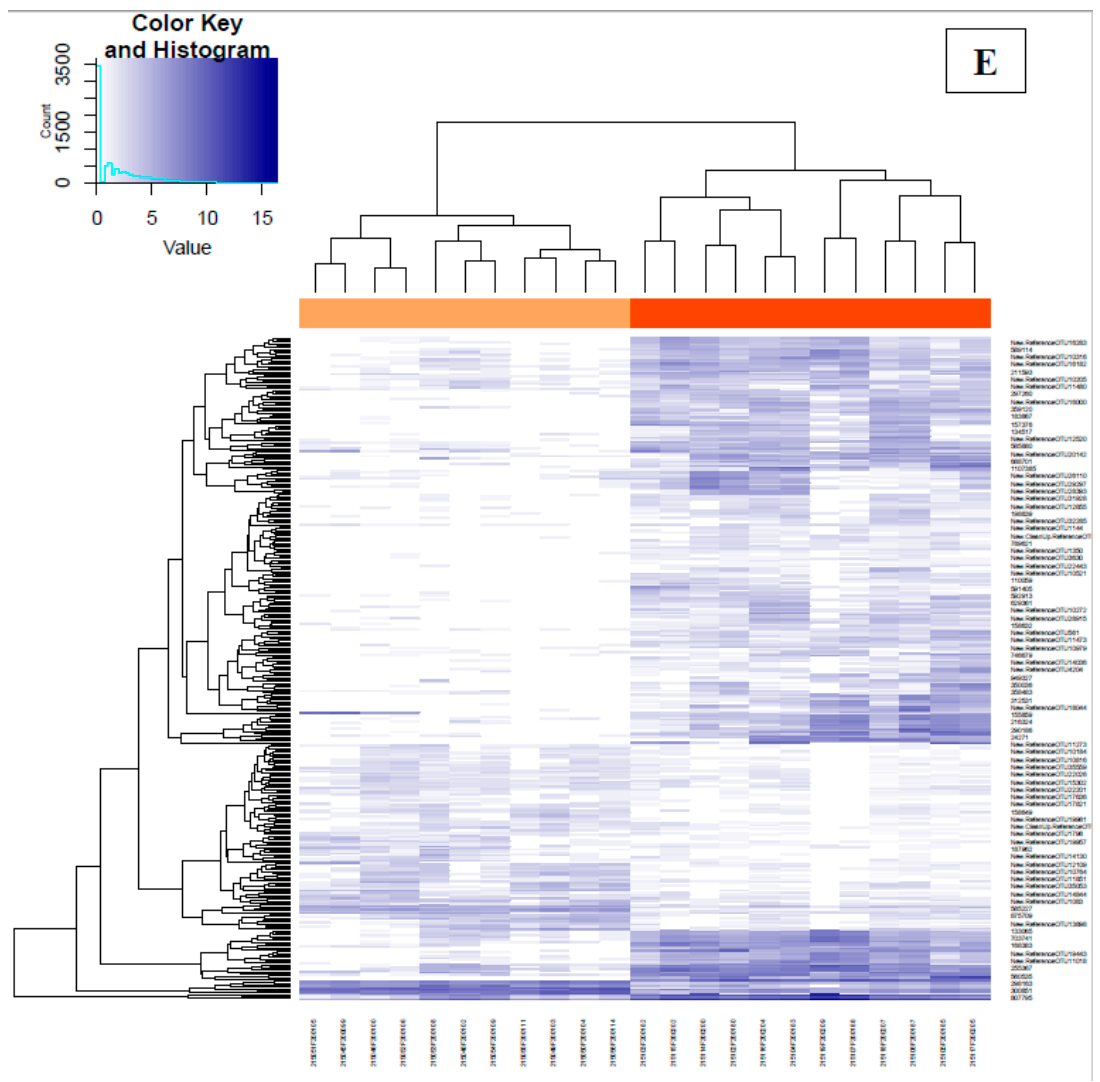
Figure 3. Dissimilarities in fecal microbiota composition represented by the NMDS ordination plot, using the Bray–Curtis dissimilarity index on OTU abundances among the C (( A ): day 21, light blue; day 40, dark blue ( A )) and S (( B ): day 21, light orange; day 40, dark orange) groups. The centroids of each group are featured as the group name on the graph (“envfit”; vegan R package). The larger filled circles indicate group centroids. ( C ) Box plot representation of the alpha diversity using the Shannon index, beta diversity (Whittaker's index) and richness using the rarefied OTUs of C (basal control diet) group at days 21 and 40. The samples are colored by time points: day 21 (light blue) and day 40 (dark blue). ( D ) Box plot representation of the alpha diversity (Shannon index), beta diversity (Whittaker's index) and richness using the rarefied OTUs of S (basal diet supplemented with Saccharomyces cerevisiae boulardii CNCM I-1079) group at days 21 and 40; samples are colored by time points: day 21 (light orange) and day 40 (dark orange). ( E ) Heat maps illustrating the abundances of differentially abundant (DA) OTUs expressed on day 21 (light orange) and d40 (dark orange) among the fecal samples of the S group (basal diet supplemented with Saccharomyces cerevisiae boulardii CNCM I-1079). The dietary treatment was used in the model of the differential analysis at the OTUs level (Figure S2B), describing among days 21 and 40, 298 DA OTUs in the C group (Table S9; Figure S3B) and 355